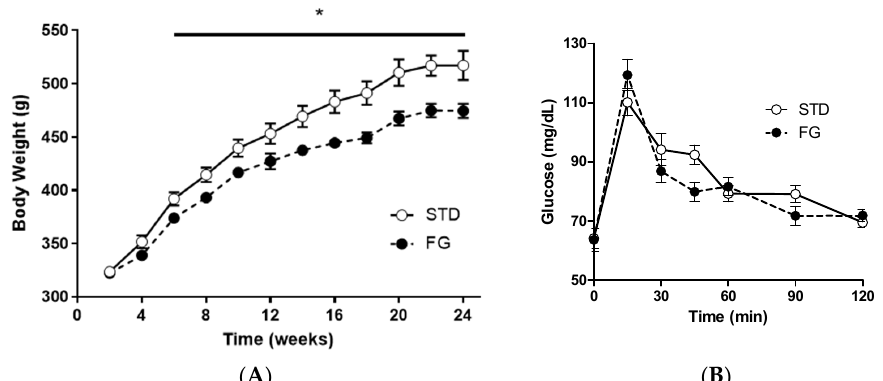
Figure 1. ( A ) Body weight evolution and ( B ) OGTT of rats ( n = 8–9) supplemented or not with D ‐fagomine for 6 months. Comparisons were conducted using ANOVA for repeated measures. * p < 0.05.